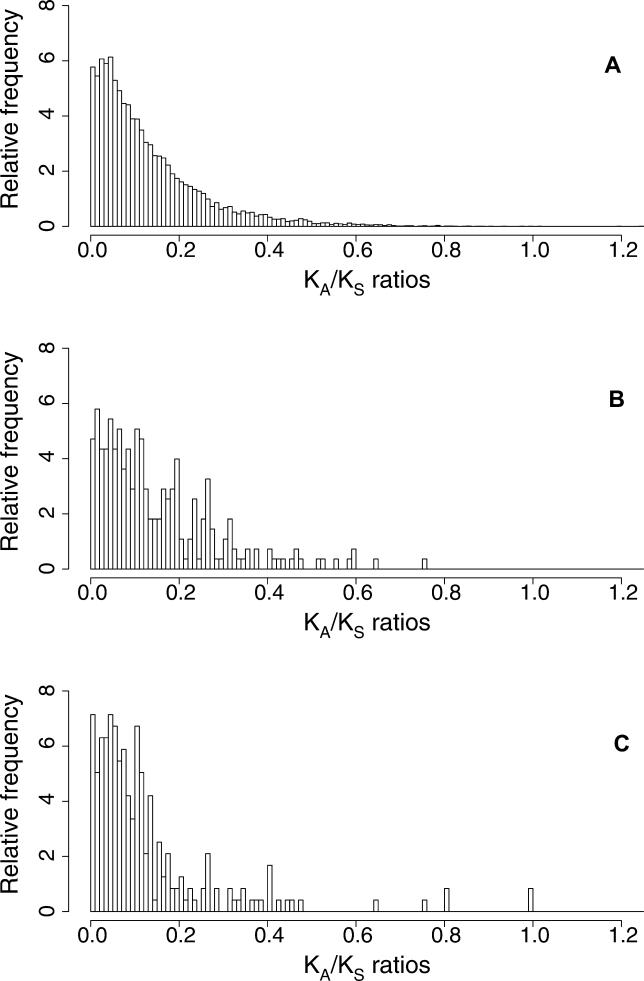
Relative Frequencies of the Ratio of KA to KS for Human–Mouse 1:1 Orthologous Genes(A) KA/KS ratios for all human–mouse orthologue pairs (median KA/KS = 0.094).(B) KA/KS ratios for orthologue pairs of human genes that are completely encompassed in human CNVs (median KA/KS = 0.112).(C) KA/KS ratios for orthologue pairs of mouse genes completely encompassed in mouse CNVs (median KA/KS = 0.081). A Kolmogorov-Smirnov test between (A) and (B) demonstrates that KA/KS values are significantly higher, on average, for human genes completely encompassed in human CNVs than for all human–mouse orthologue pairs (p = 1.7 × 10−2). On the other hand, genes completely encompassed in mouse CNVs exhibit significantly lower KA/KS values than all human–mouse orthologue pairs (p = 3.3 × 10−3).